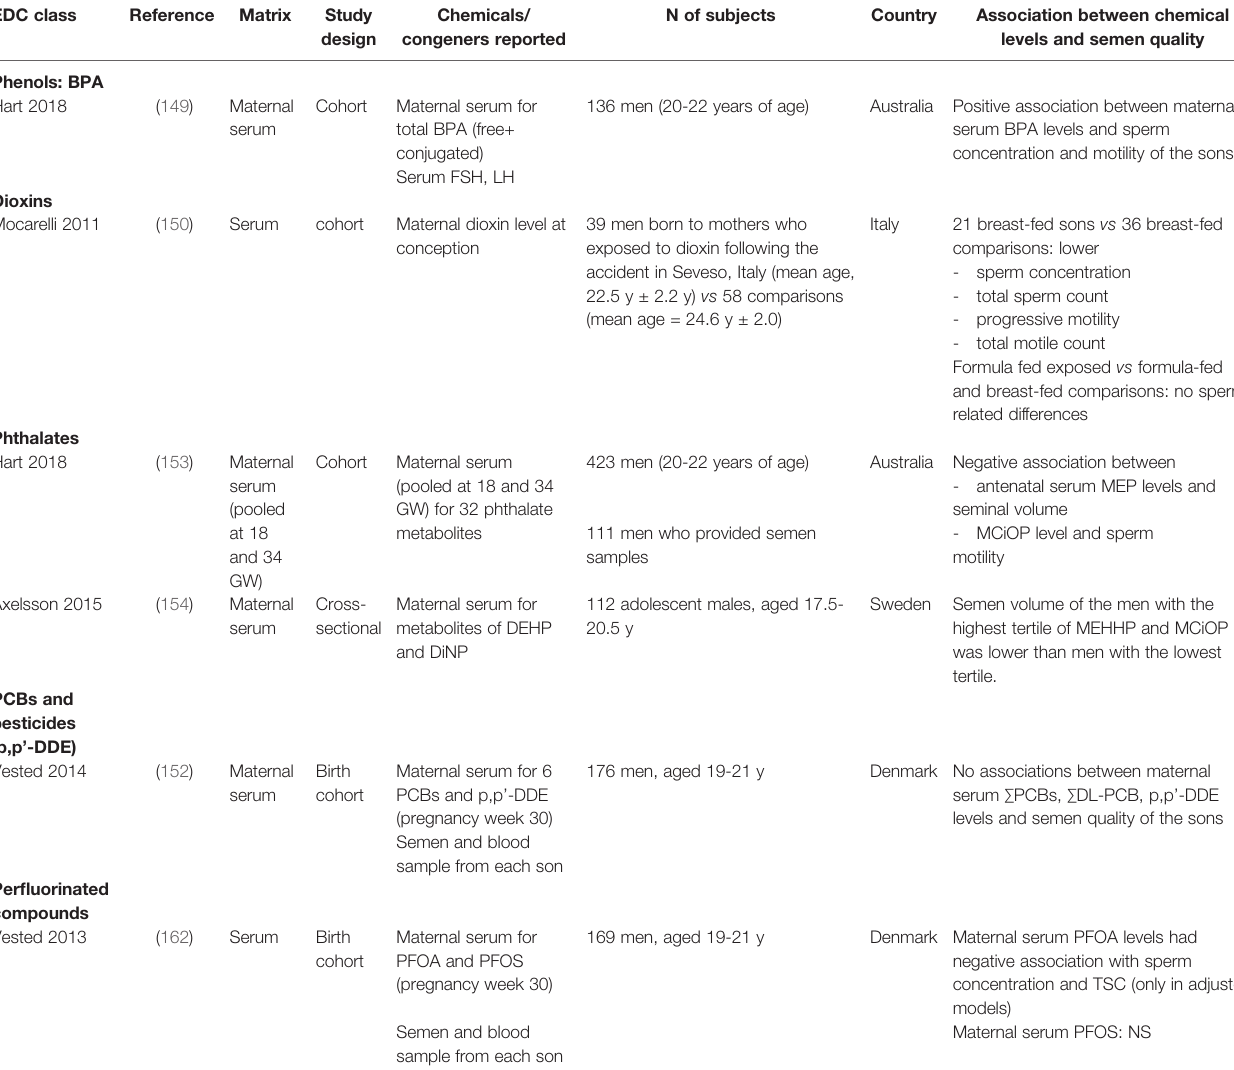
TABLE 4 | Studies on early life endocrine disrupting chemical exposure and associations with semen quality.